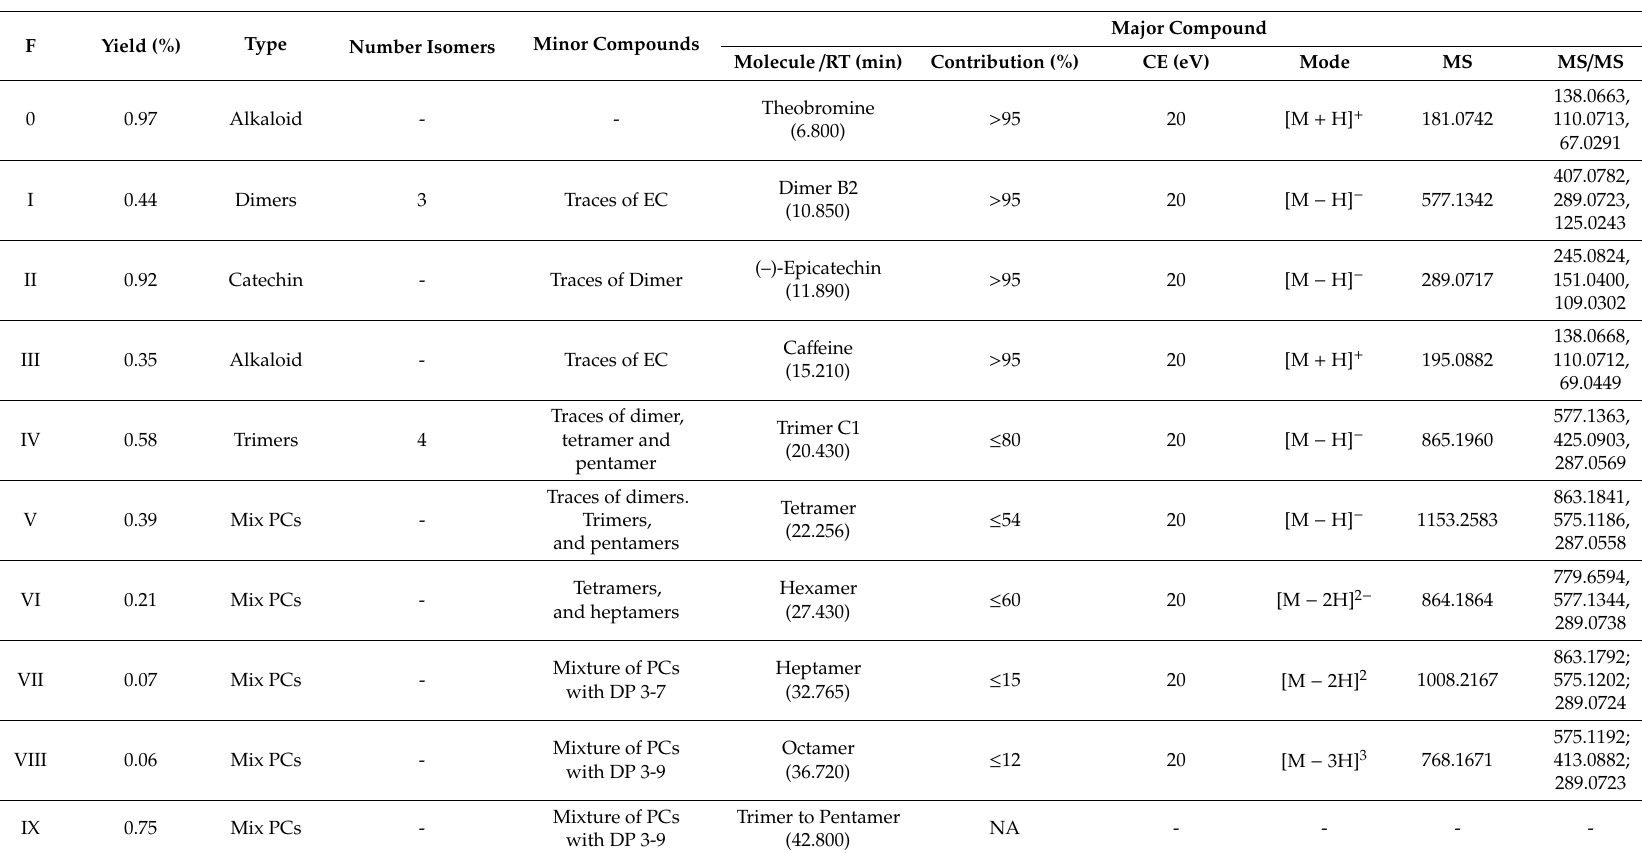
Table 1. Yield, purity, characterization, and structural mass pattern for each procyanidin fraction from cocoa polyphenolic extract using obtained by preparative reversed